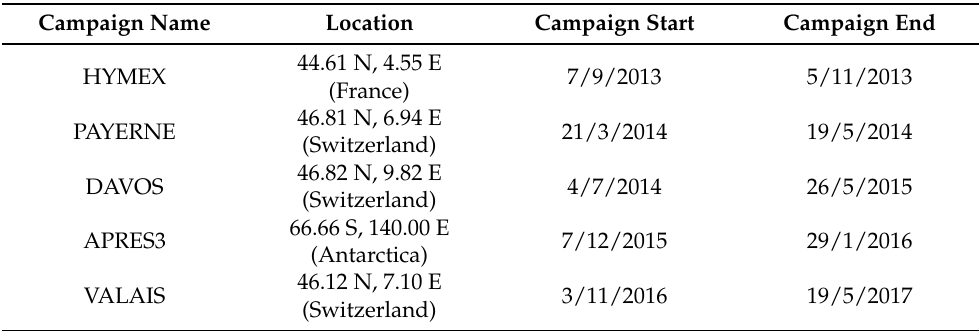
Table 1. List of the names, locations, and dates of the field campaigns involving MXPol used in the